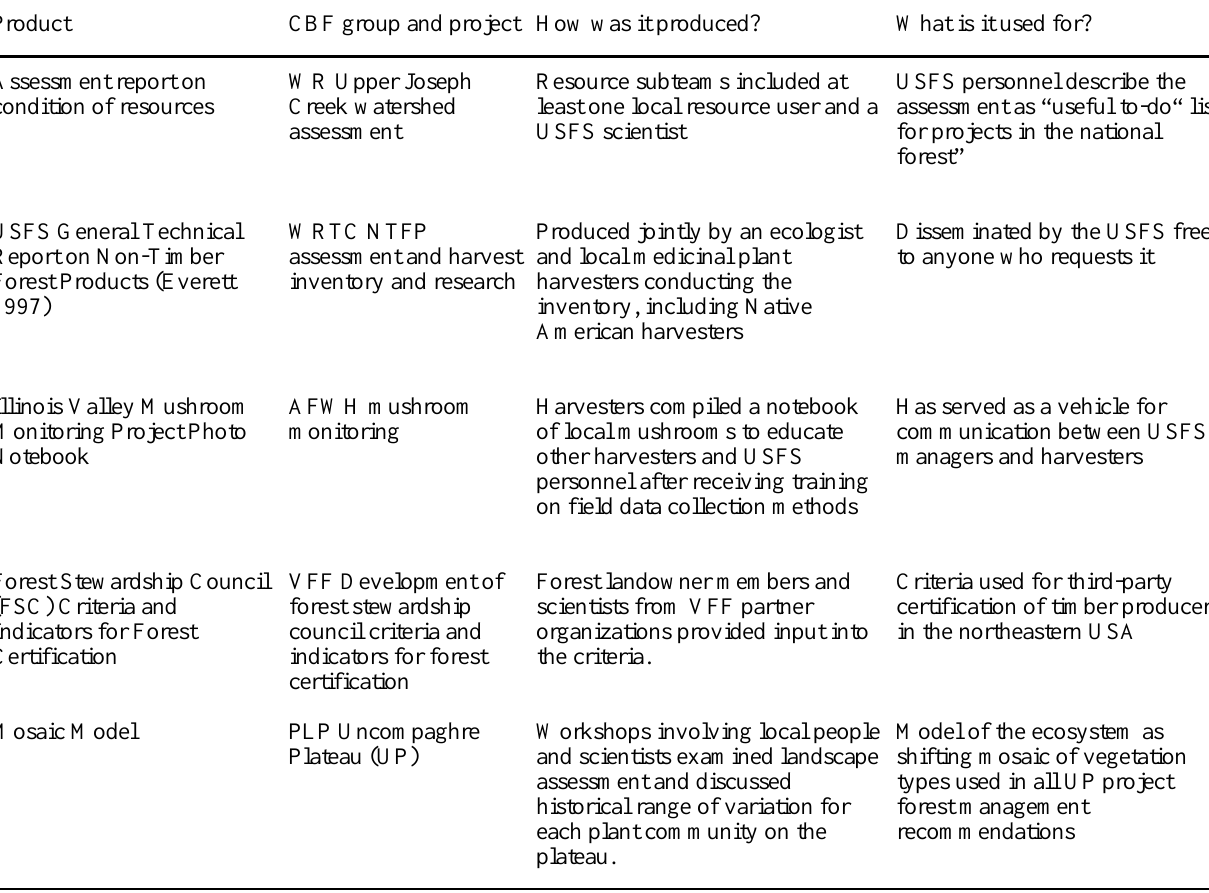
Table 3 . Products of community-based forestry groups that included both local ecological knowledge and conventional